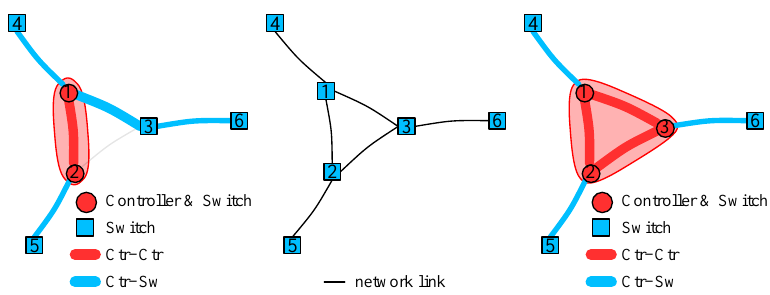
Figure 1. Toy example: The left controller placement increases the Ctr–Sw traffic, while the right controller placement increases the Ctr–Ctr traffic. The line widths of the edges are proportional to the bandwidth required by the respective